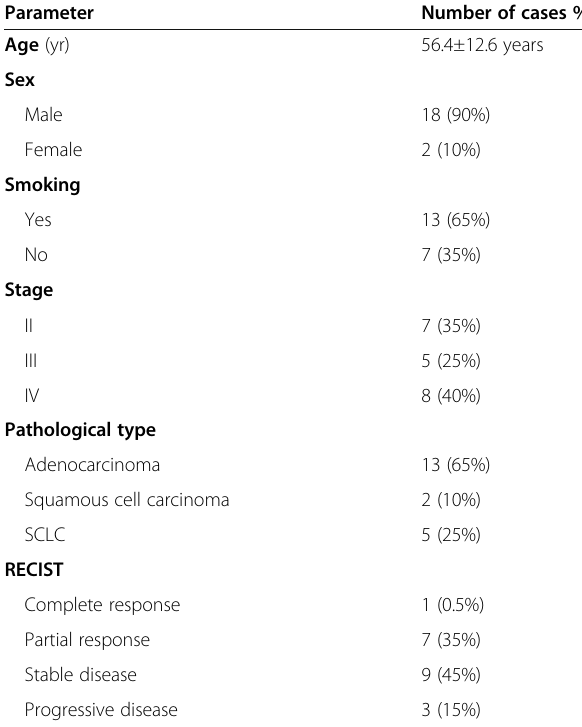
Table 1 Demographic parameters and clinical data of the patients